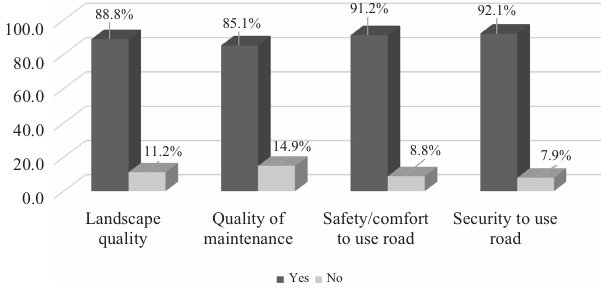
Figure 5. Road users ’ assessment of various beneficial aspects of thelandscapingofroad median strip